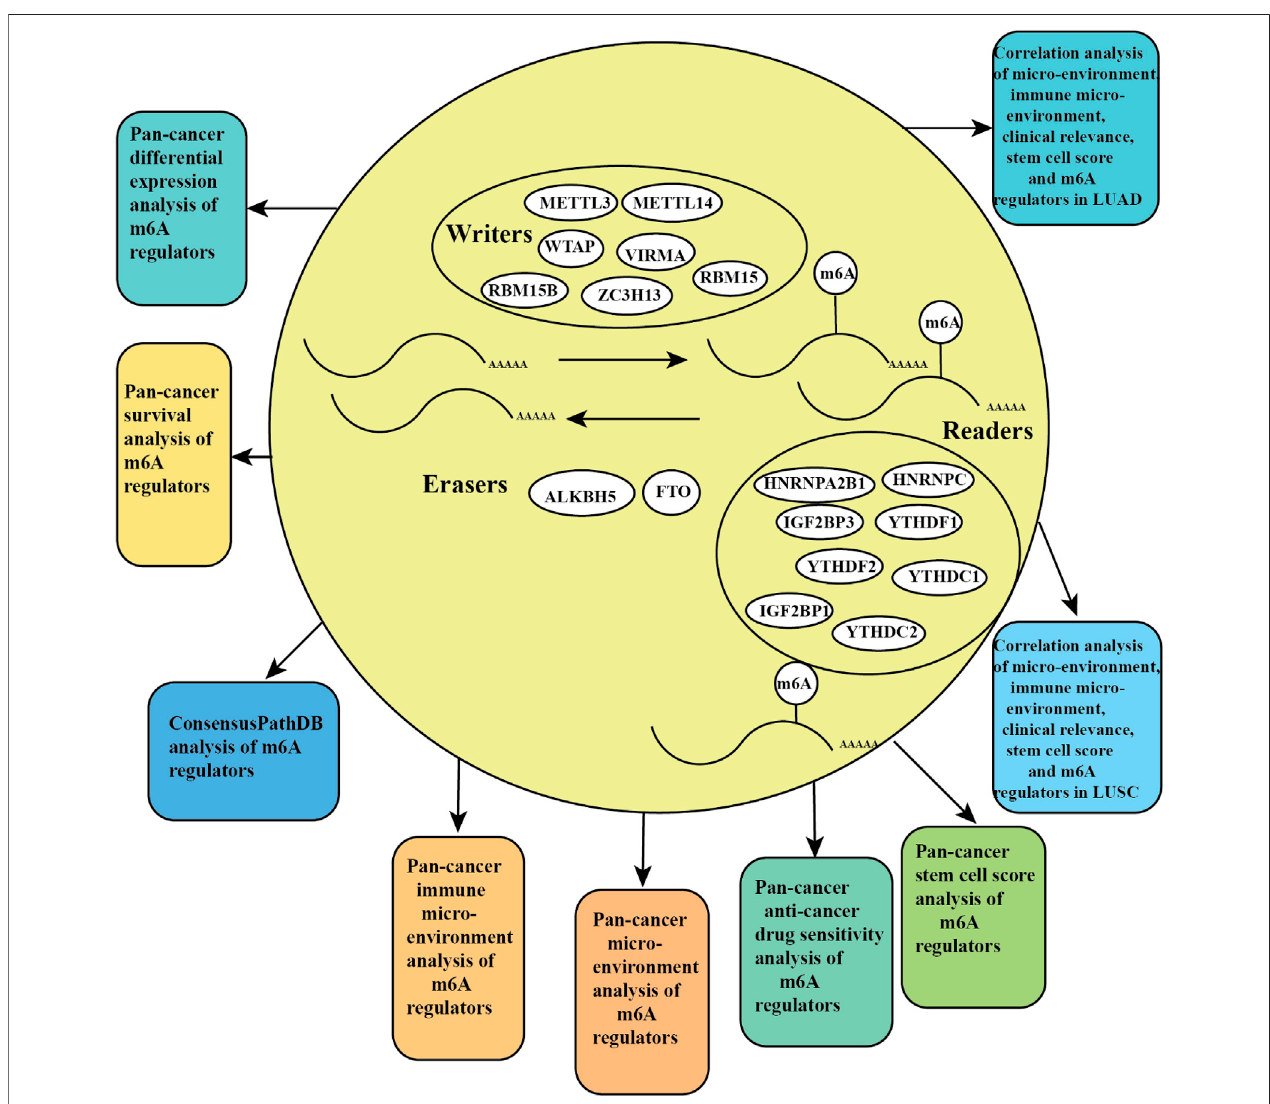
FIGURE 10 | Pictorial representation of m6A regulation combined our fi